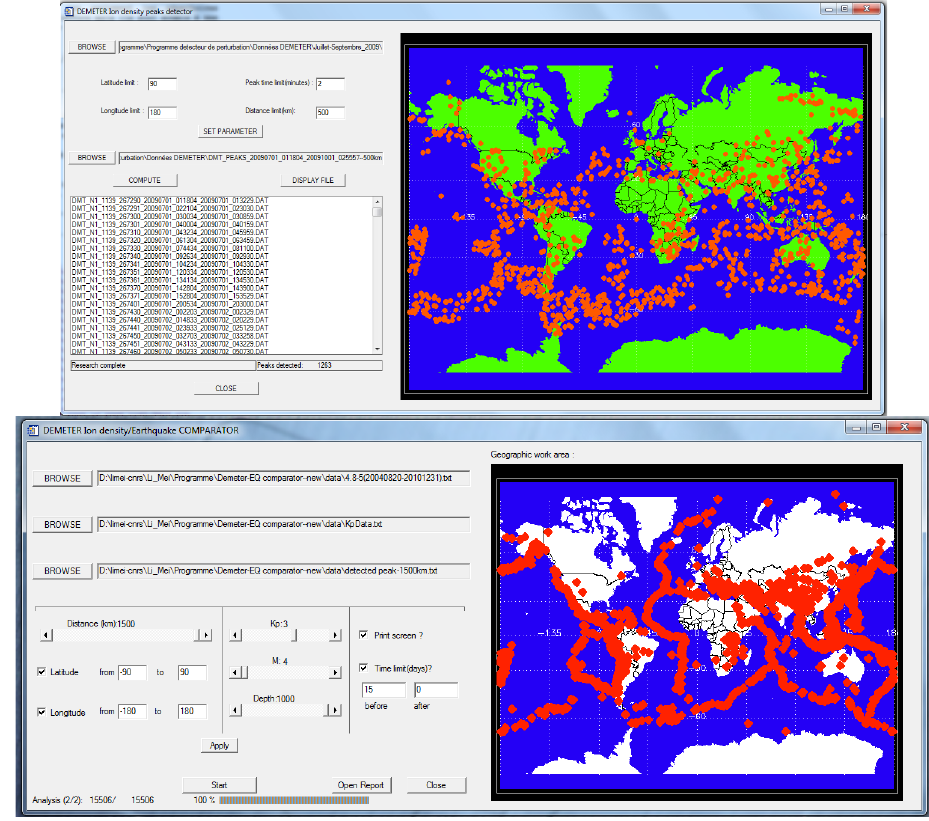
Fig. 1. View of the interfaces with the software to tune the parameters. Top panel for the first software (the data used are from 1 July to 1 October 2009). Bottom panel for the second software.